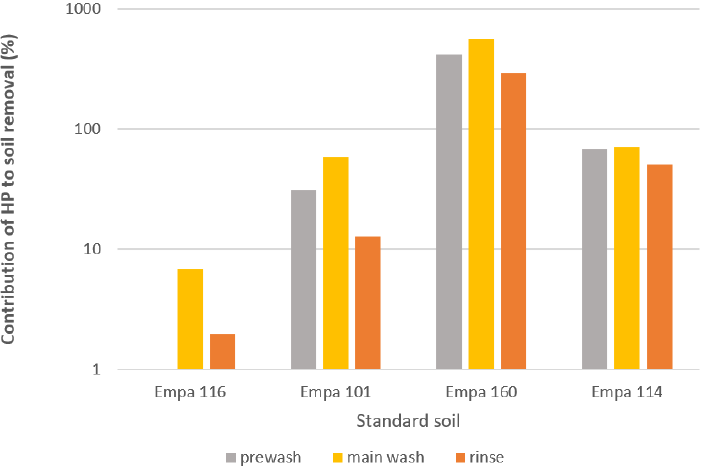
Figure 4. Contribution of HP a to soil removal after washing in the studied wash cycles. a Contribution of HP was determined as a ration between Δ Ls * of the standard soil sample washed with 3% HP and Δ Ls * of the same standard soil sample washed without 3% HP.